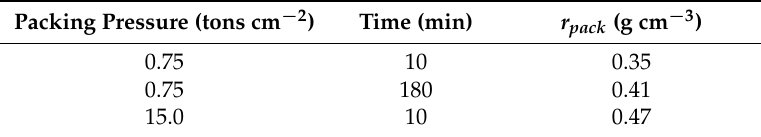
Table 5. Packing density ( r pack ) of KUPO16-2-750 samples pressed at different pressures for variable